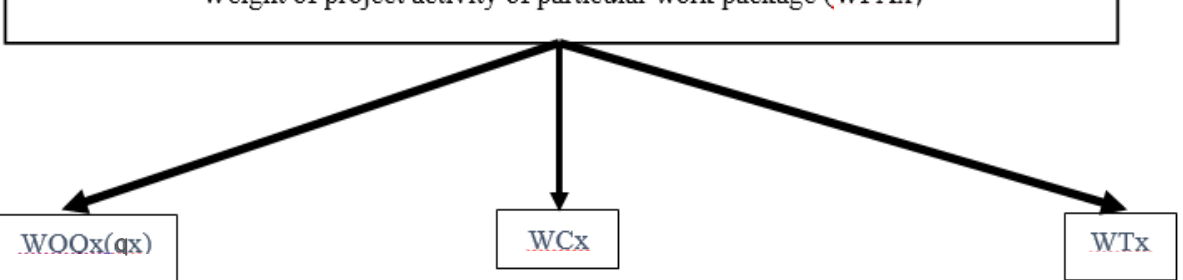
Figure 6. Weight distribution of particular project activity on activity output quality parameters, activity time and activity